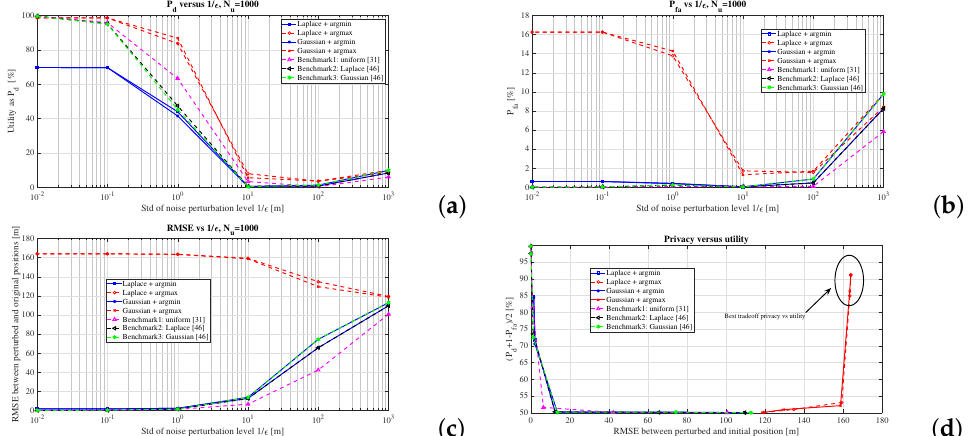
Figure 7. Comparison with state-of-the-art algorithms: ( a ) P d versus the noise perturbation level; ( b ) P fa versus the noise perturbation level; ( c ) RMSE between the perturbed location and original location versus the noise perturbation level; ( d ) utility versus